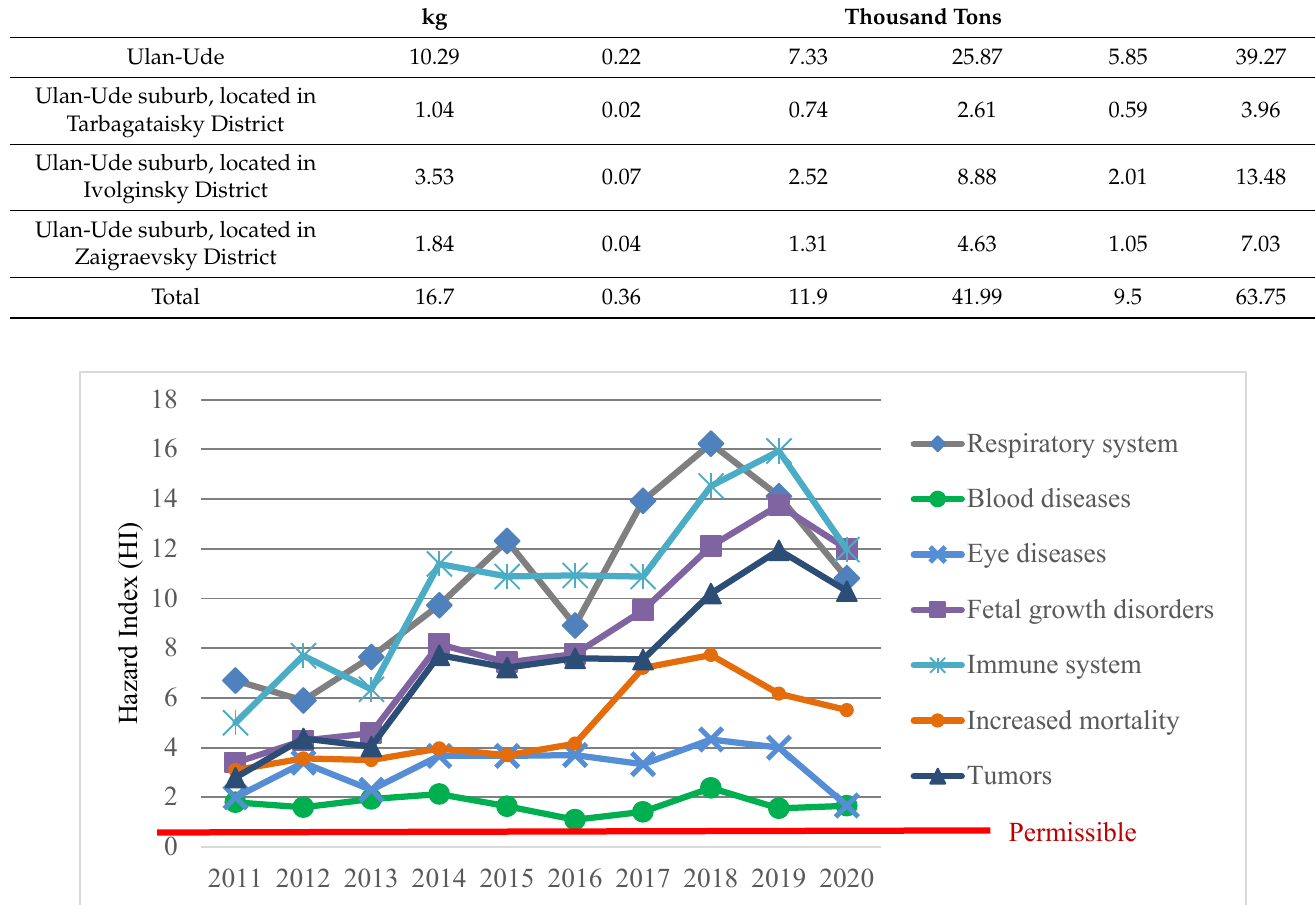
Figure 2. Hazard indices (HI) of non-carcinogenic risk to public health in Ulan-Ude with unidirec- tional effects of atmospheric air pollutants on human organs and systems in 2011–2020. The hazard indices of non-carcinogenic risks to the health of the population of Ulan- Ude exceeded the permissible levels due to the content of pollutants in the air such as benzo( a )pyrene (HQ = 10.3), formaldehyde (HQ = 1.7), suspended solids (HQ = 1.7), PM 10 (HQ = 1.5), PM 2.5 (HQ = 1.8), and nitrogen dioxide (HQ = 1.1). The level of individual carcinogenic risk for the population of Ulan-Ude was 1.62 × 10 − 4 , which is considered “acceptable for professional groups and unacceptable for the population”. Priority pollutants in the atmospheric air that formed the carcinogenic risk were black carbon (52.1%, CR = 0.84 × 10 − 4 ) and formaldehyde (40.7%, CR = 0.66 × 10 − 4 ) (Figure 3). Statistics for the period 2011–2020 show that for some risk-related diseases, the mor- bidity of the population in Ulan-Ude exceeds the average figures for the Republic of Buryatia. The total morbidity rate in Ulan-Ude was 1.2 times higher than the average in Buryatia and amounted to 77,077.63 cases per 100 thousand people (63,985.43 cases per 100 thousand people in Buryatia). Respiratory system morbidity in Ulan-Ude was 34,154.29 cases per 100 thousand people, which is 1.19 times higher than the average for Buryatia (28,648.46 per 100 thousand people). Corresponding exceedances were